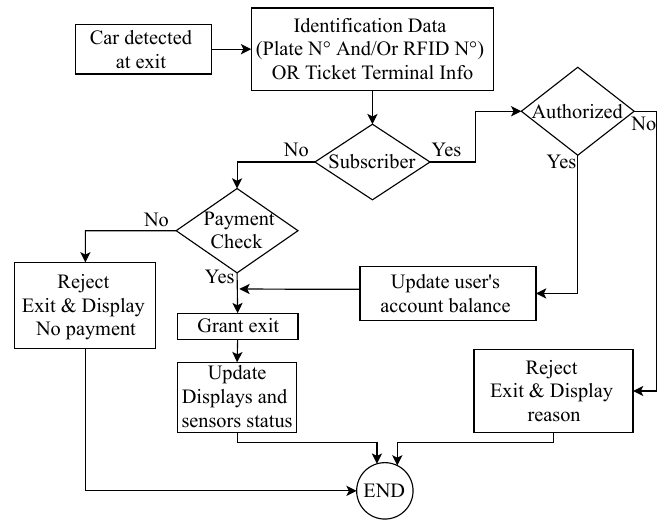
Figure 5. The parking exit scenario.